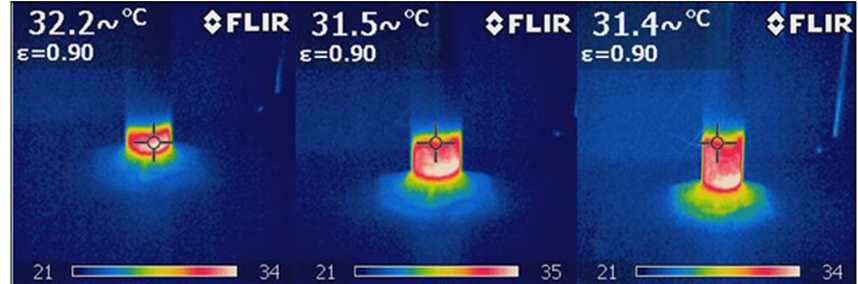
Figure 3. Images of the PCM undergoing melting in the cylinder for heater input power of 1.6 W (2.8 V input condition).